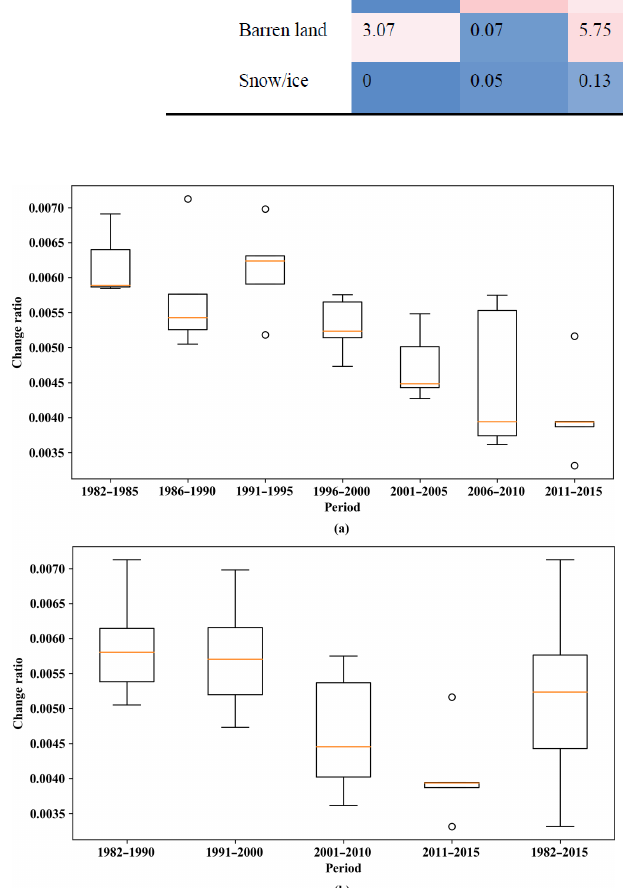
Figure 10. Comparison and distribution of ratios of annual global land cover change (LCC) to the global total terrestrial land cover (LC) area by different time periods and time intervals: (a) 5-year in- terval and (b) 10-year interval. The box extends from the first quar- tile (Q1) to third quartile (Q3) values of the data, with an orange line at the median. The upper whisker extends to the last datum less than Q3 + 1 . 5 × IQR, and the lower whisker extends to the first da- tum greater than Q1 − 1 . 5 × IQR. Flier points are those past the end of the